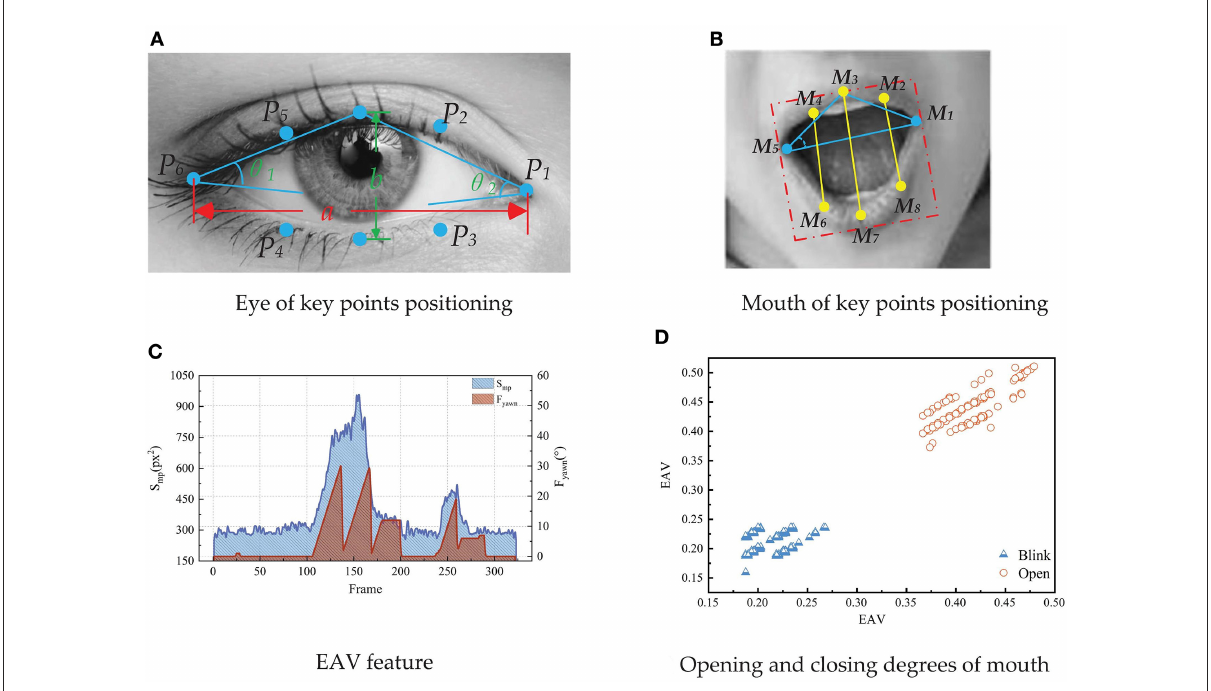
FIGURE8 The feature of eye and mouth, including eye of key points positioning (A) , mouth of key points positioning (B) , EAV feature (C) , and opening and closing degrees of mouth (D) .